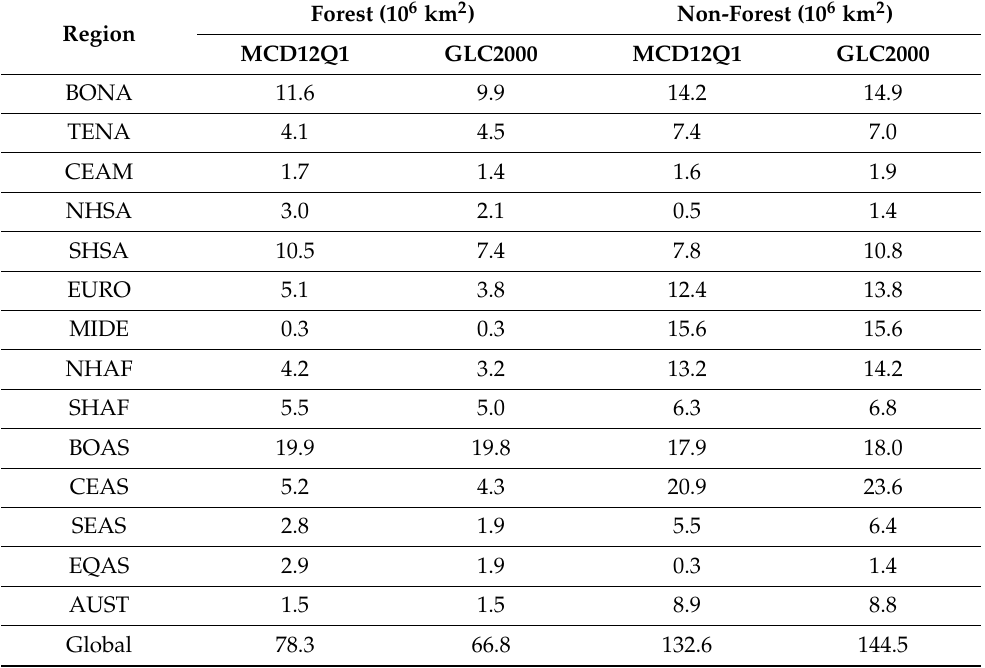
Table 4. Forest and non-forest areas in each region for the LCC maps. Forest and non-forest areas in MCD12Q1 are the averages from 2001 to 2018. Regions of “water,” “no-data” categories, and “Antarctica” are excluded.